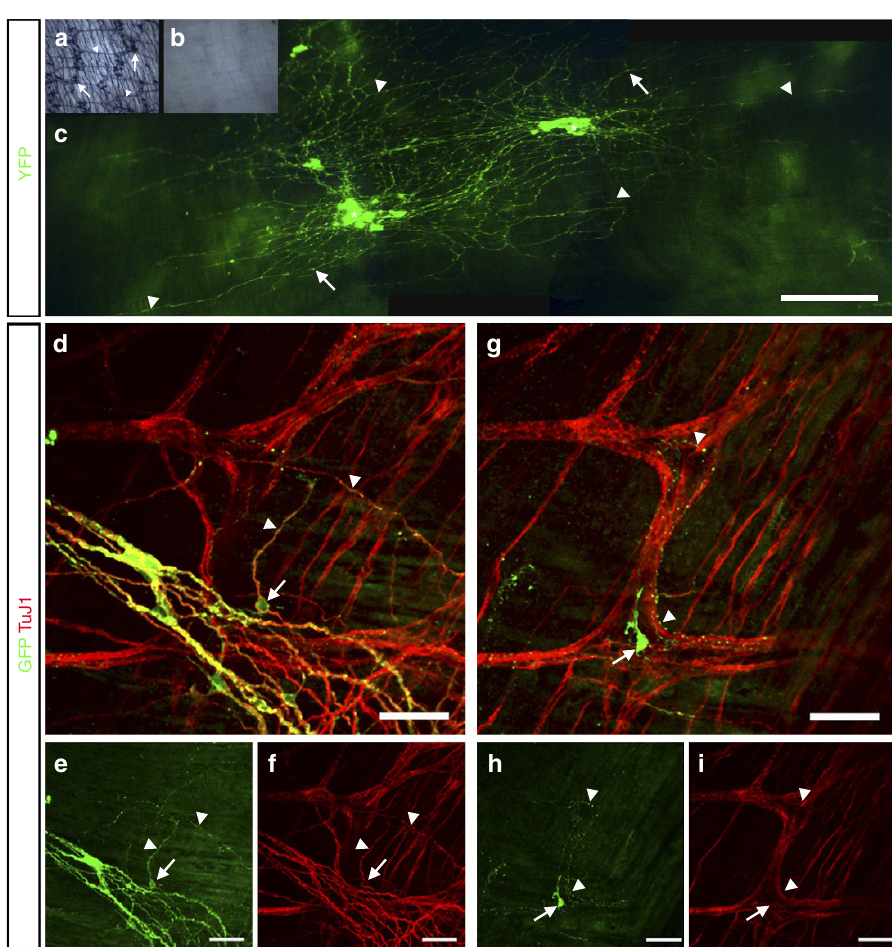
Figure 1 | Transplanted ENSC extensively colonize and integrate within the nNOS (cid:2) / (cid:2) mouse colon. ( a ) Representative image of NADPH diaphorase staining in wild-type C57BL/6J. nNOS þ cell bodies (arrows), within enteric ganglia, and nNOS þ fibres (arrowheads) are indicated. ( b ) Representative image of NADPH diaphorase staining of nNOS (cid:2) / (cid:2) mouse colon demonstrating loss of nitrergic innervation with the absence of NADPH diaphorase staining. ( c ) Representative stereoscopic montage image of transplanted YFP þ cells within the nNOS (cid:2) / (cid:2) distal colon at 4 weeks. Transplanted cells form large anastomosing networks comprising cell bodies (arrows) and fibres (arrowheads), including ganglia-like structures (asterisk). Scale bar, 500 m m. ( d ) Example confocal image demonstrating co-expression of the neuronal marker TuJ1 within YFP þ -transplanted cells. YFP þ cell bodies (arrow) project fibres (arrowheads) towards the endogenous neuronal network at the level of the myenteric plexus. ( e , f ) Individual channels showing GFP and TuJ1 staining from d . ( g ) Representative confocal image demonstrating the presence and integration of transplanted cells within endogenous ganglia. At the level of the myenteric plexus, fine GFP þ fibres and varicosities encompass and trace endogenous neuronal fibre tracts (arrowheads). GFP þ cells were also identified within ganglia (arrow). ( h , i ) Individual channels taken from g showing GFP and TuJ1 staining at the level of the myenteric plexus. Scale bar, 50 m m ( d – i